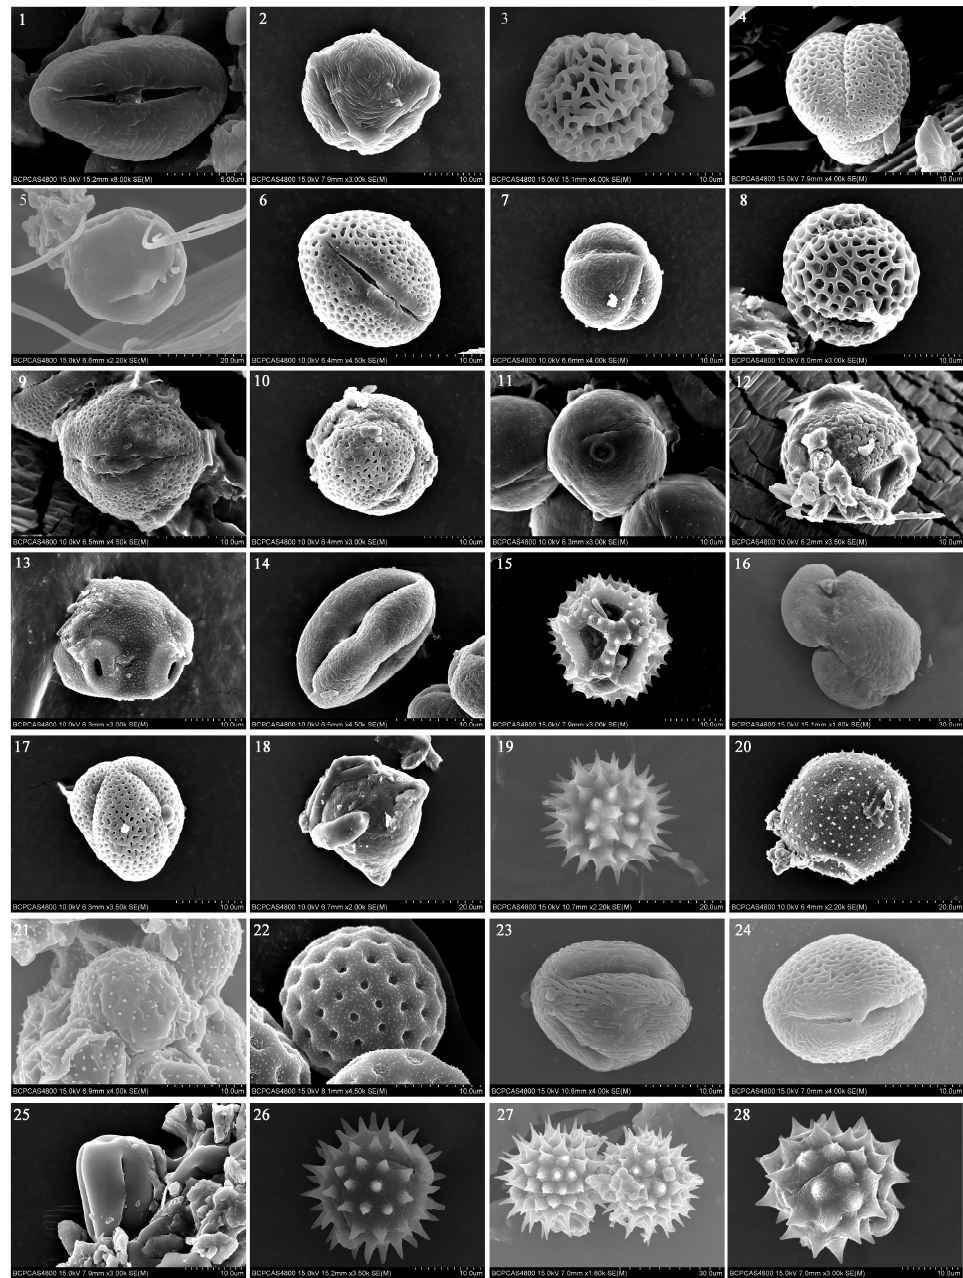
Figure 1. Scanning electron microscopy (SEM) microphotographs of the examined pollen species. 1. Castanea mollissima ; 2. Prunus yedoensis/Prunus subhirtella/Prunus serrulata ; 3. Ligustrum lucidum/Ligustrum sempervirens ; 4. Citrus sinensis ; 5. Melia azedarach ; 6. Flueggea virosa ; 7. Hoboellia parviflora/Hoboellia grandiflora ; 8. Olea europaea ; 9. Amorpha fruticosa ; 10. Alniphyllum fortunei ; 11. Robinia pseudoacacia ; 12. Llex cornuta/Ilex corallina ; 13. Pterocarya rhoifolia ; 14. Castanopsis echinocarpa ; 15. Taraxacum officinale/Taraxacum platypecidium ; 16. Pinus tabuliformis/Pinus thunbergii/Pinus nigra/Pinus densiflora/Pinus kesiya/Pinus sylvestris/Pinus tropicalis ; 17. Brassica rapa/Brassica napus/Brassica oleracea/Brassica juncea ; 18. Elaeagnus umbellata ; 19. Helianthus annuus ; 20. Adenophora trachelioides/Adenophora remotiflora ; 21 . Smilax L.; 22. Chenopodium album ; 23 . Rosaceae; 24. Rosaceae; 25. Violaceae (close to Viola ); 26. Compositae (close to Coreopsis, Sigebeckia ); 27. Compositae (also similar to Cosmos , Kalimeris , Aster ); 28. Aster L. (also similar to Chrysanthemum , Matricaria ).